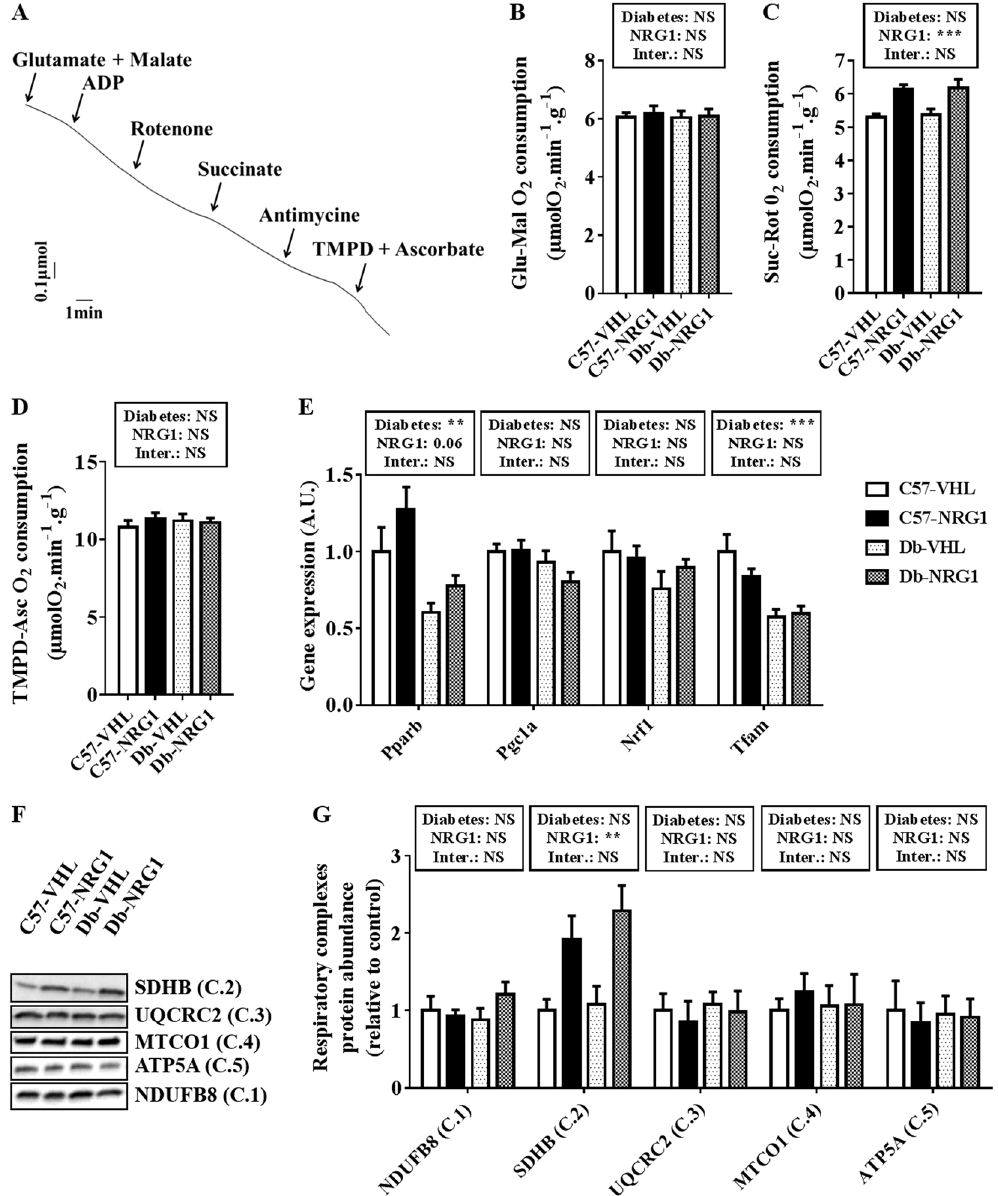
Figure 1. NRG1 treatment improves complex 2-mediated mitochondrial respiration in gastrocnemius muscle. C57BL/6JRJ (C57) and db/db (Db) male mice were treated with vehicle (VHL; 0.9% NaCl solution; n = 8/ condition) or with NRG1 (50 μ g . kg − 1 ; n = 8/condition), three days per week for eight weeks. Representative recording ( A ) of ADP-stimulated maximal mitochondrial O 2 consumption assessed in permeabilised gastrocnemius muscle fibres with glutamate and malate (Glu-Mal) ( B ), succinate and rotenone (Suc-Rot) ( C ) or TMPD and ascorbate (TMPD-Asc) ( D ) as substrates and inhibitors. The expression of genes involved in mitochondrial biogenesis ( Pparb , Pgc1a , Nrf1 and Tfam ) was assessed by RT-qPCR ( E ). The abundance of respiratory complex subunits was analysed by western blotting (( F ) cropped images). Quantification of the abundance of respiratory complexes subunits ( G ) was relative to the level in untreated healthy mice (C57-VHL, white bars). Gene expression levels were calculated using the absolute quantification method and a cDNA calibration curve, and it is shown as relative change of the expression in untreated healthy mice (C57-VHL, white bars). Results are the mean ± SEM, (n = 8 per group). The diabetes (healthy vs db/db mice) and NRG1 (saline vs NRG1) effects were investigated with a 2 × 2 ANOVA. When a significant interaction was found, the Tuckey’s test was used for post-hoc multiple comparisons. ** p < 0.01, *** p < 0.001, NS: not